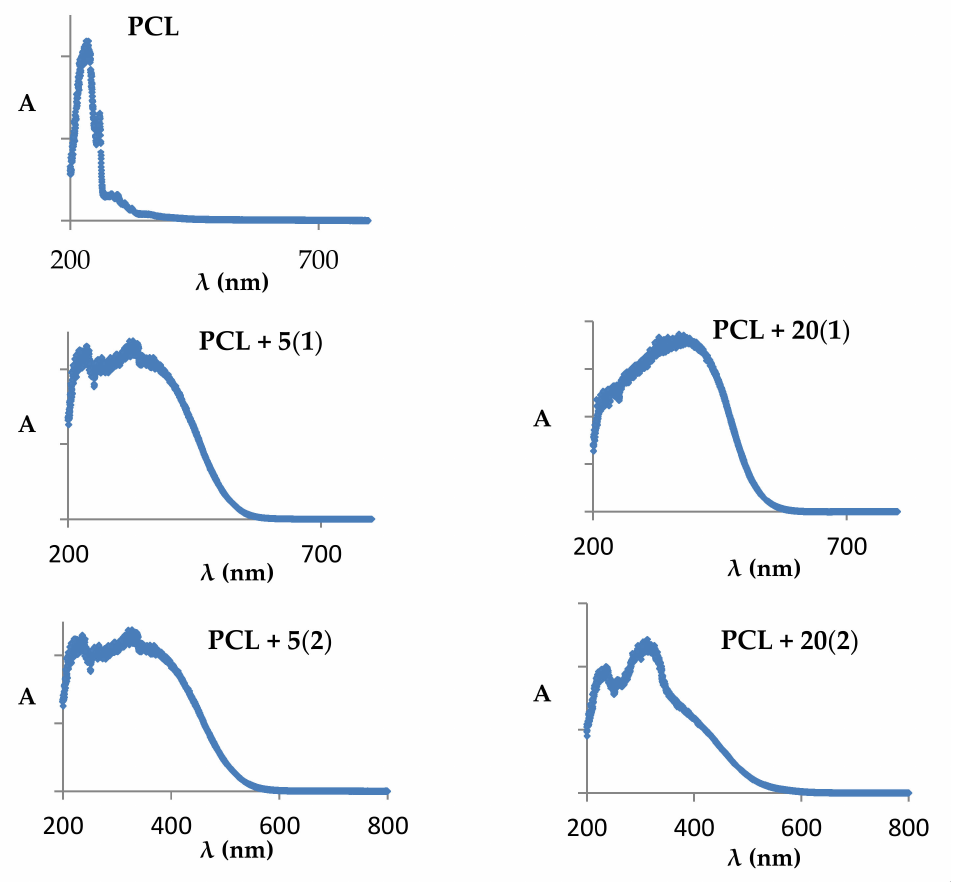
Figure 6. UV–Vis–DRS spectra of PCL and studied PCL + nTOCs